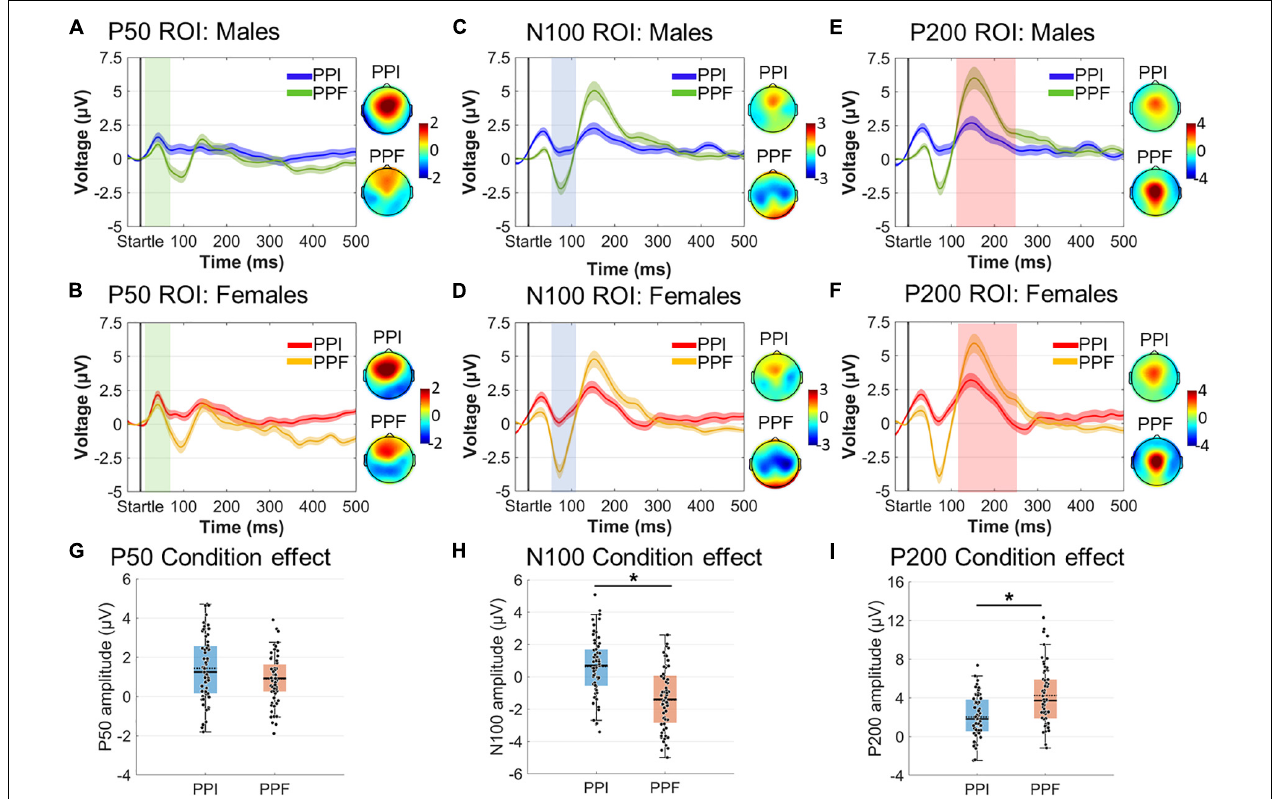
FIGURE 6 | Grand-averaged ERP responses for each group (males vs. females) and condition (PPI vs. PPF). (A–F) The time course of the component- and ROI-specific ERP responses are illustrated for males (PPI: blue, PPF: green) and females (PPI: red, PPF: orange), respectively, from –30 to 500 ms (time 0 is the startle onset). Color-shaded areas correspond to the time course of the standard error ( ± 1 SE) of the mean. ERP component topographies are shown on the right of each plot. (G–I) The descriptive statistics (mean and median) of condition main effects are depicted as scatter boxplots for each ERP component. *Significant differences between PPF and